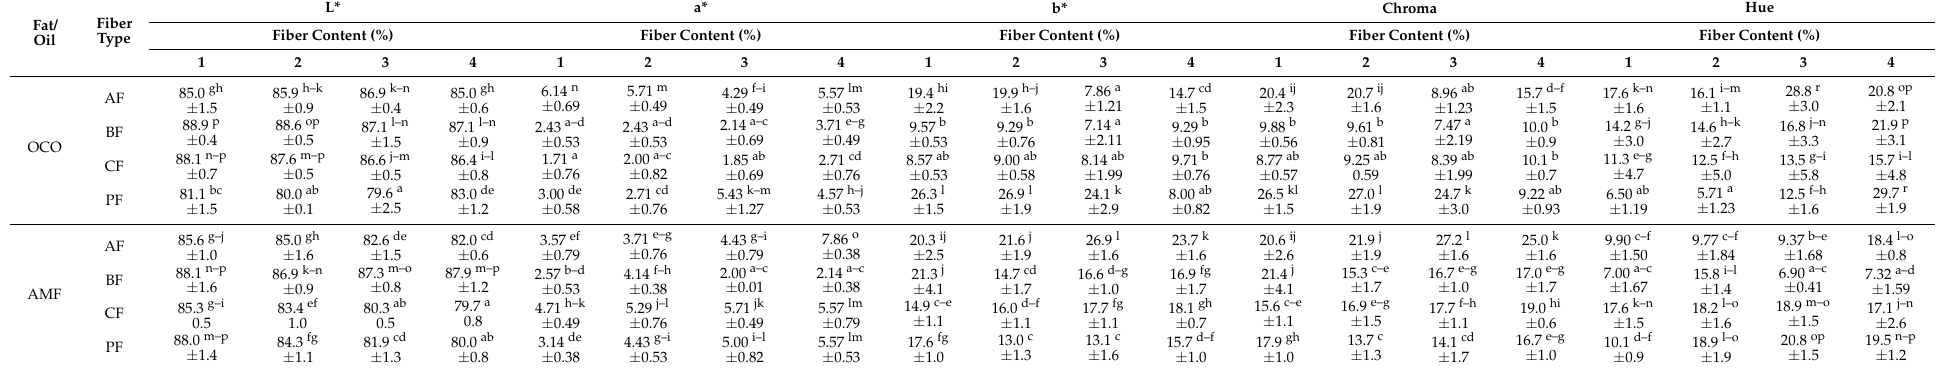
Table 3. Effect of different fibers concentration color (CIE Lab standards) of acid casein PCS (processed cheese sauces) with WPC80 (whey protein concentrate) and OCO (organic coconut oil) or AMF (anhydrous milk